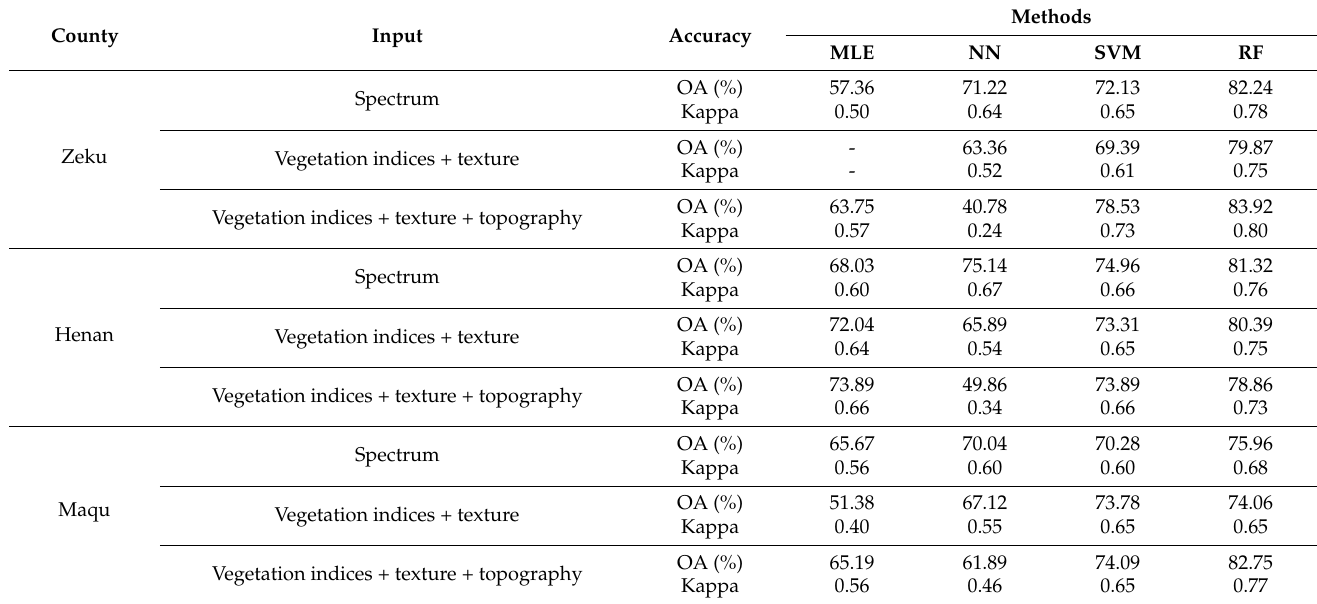
Table 4. Overall accuracy and Kappa coefficient of eight land covers based on maximum likelihood estimate (MLE), neural network (NN), support vector machine (SVM) and random forest (RF) and difference input data set in County of Zeku, Henan and Maqu.